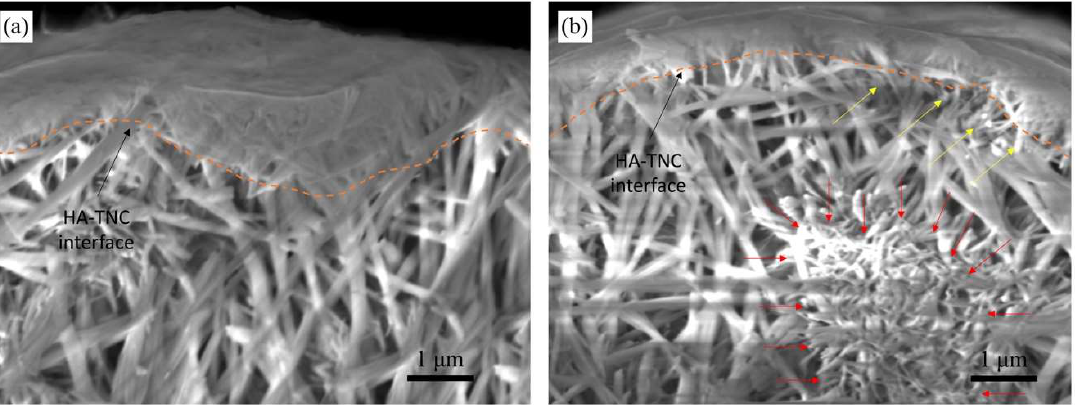
Figure 6. Cross-sectional analysis of the HA-TNC coating ( a ) before and ( b ) after corrosion testing.